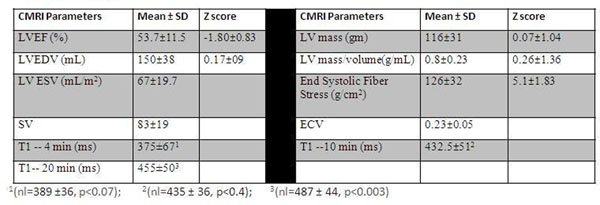
CMRI parameters